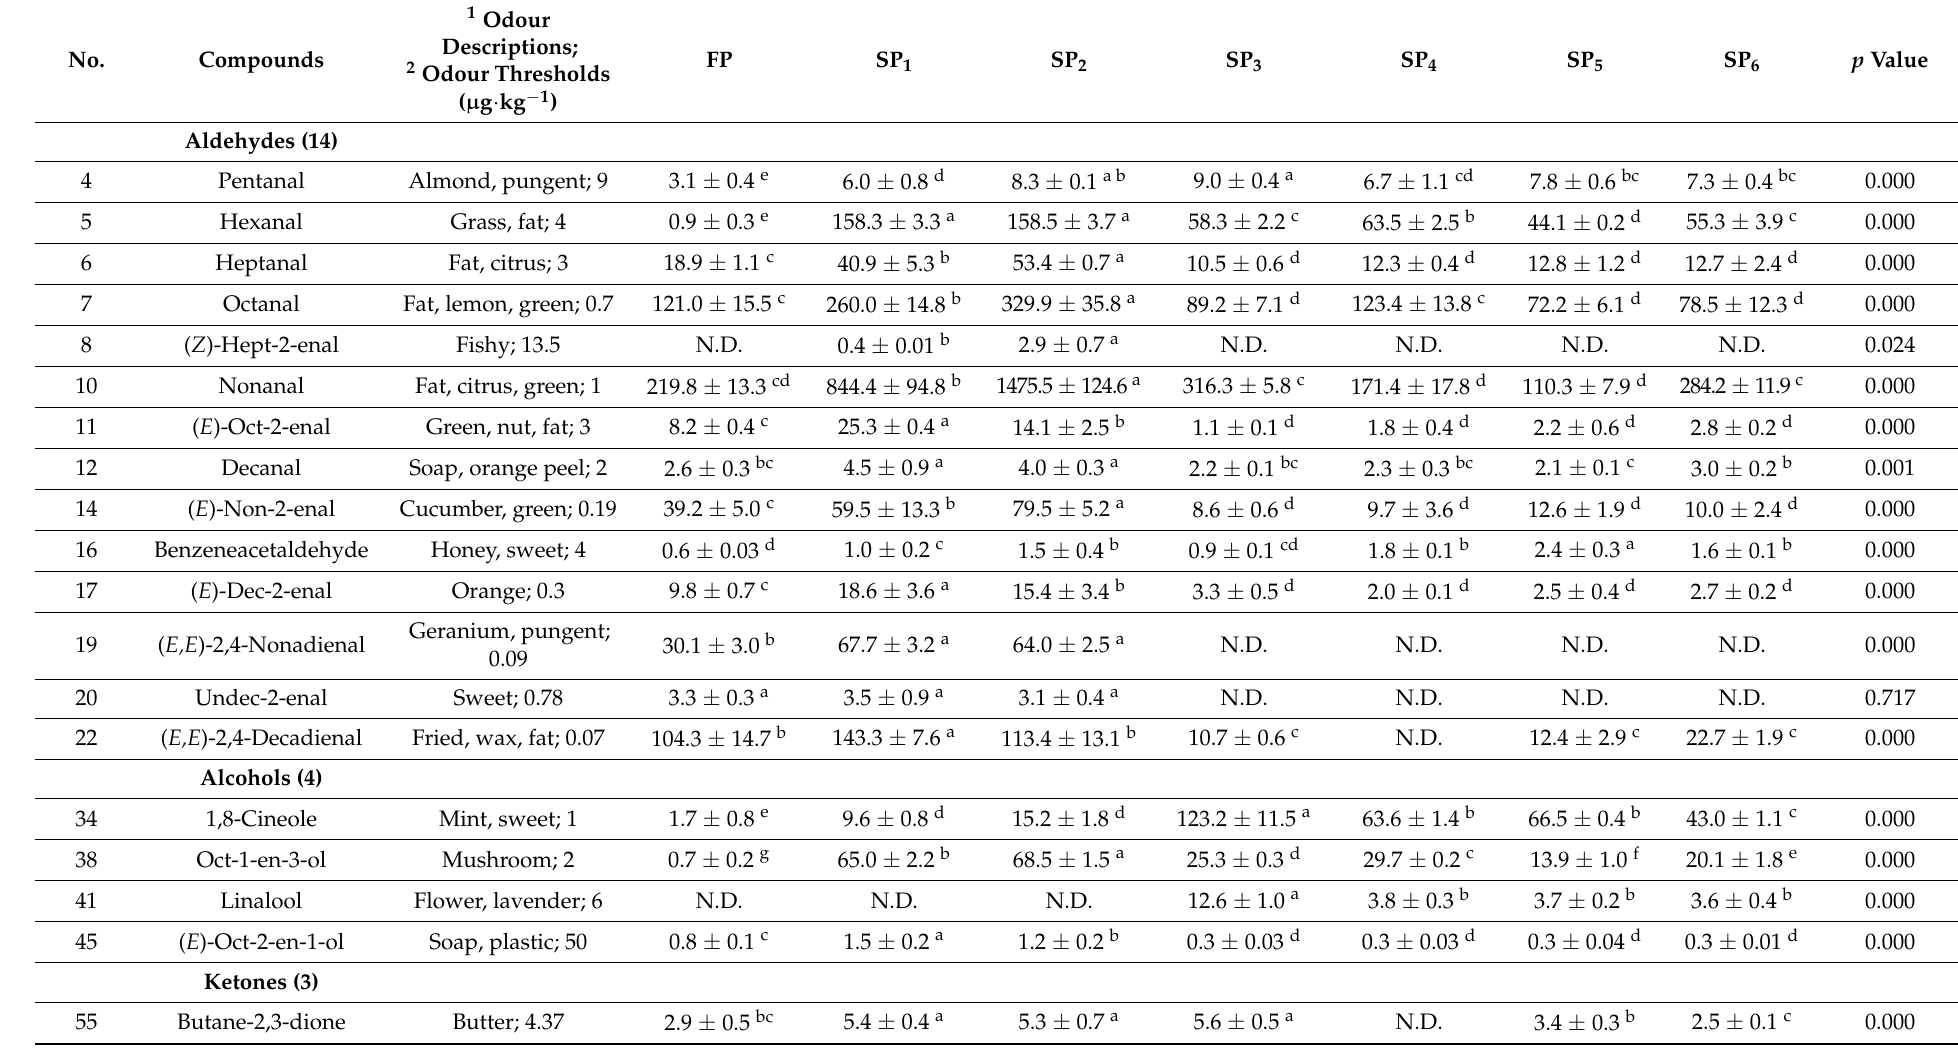
Table 3. Odour-active compounds (OAVs > 1) in the fresh and stewed